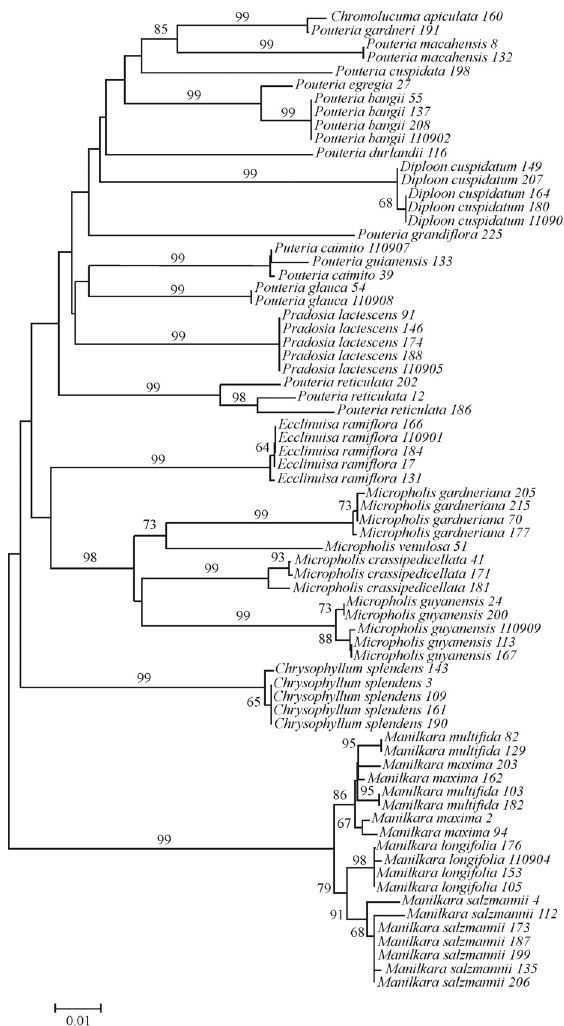
Figure 3 - Neighbor-joining tree based on analysis of the ITS region. The numbers above the nodes correspond to bootstrap values > 50%. The scale indicates the Kimura 2-parameter (K2P)